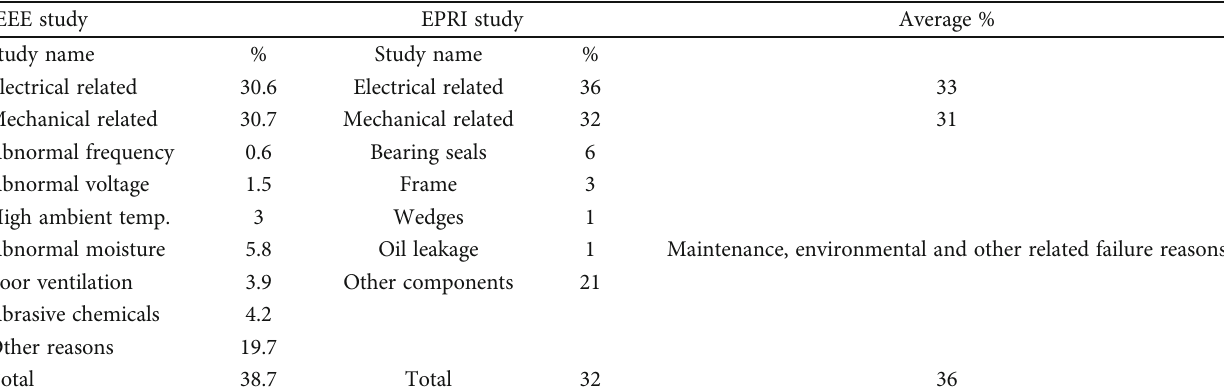
Table 1: Motor failure percentage